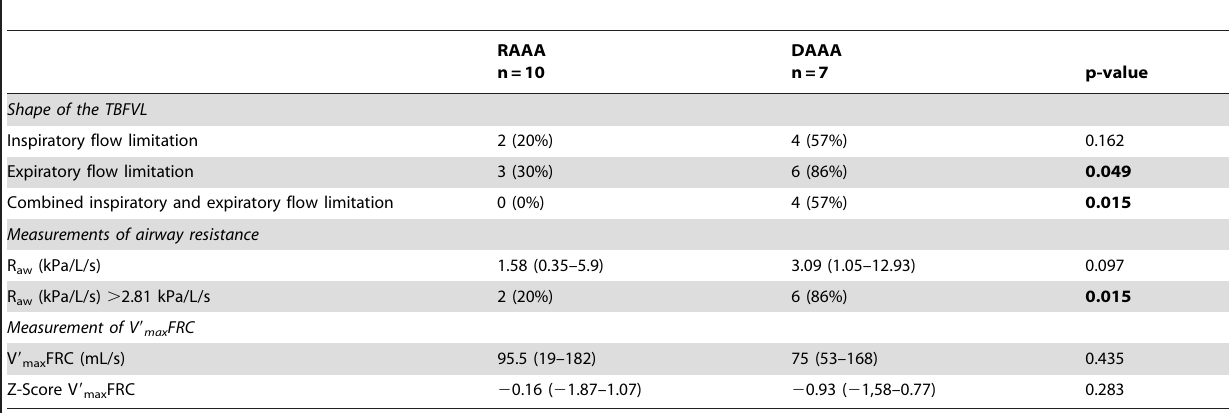
Table 2. Comparison of the results of lung function testing in infants with right-sided and double-sided aortic arch anomaly (presented as median (range) or n (%), statistically significant p-values are printed in bold).